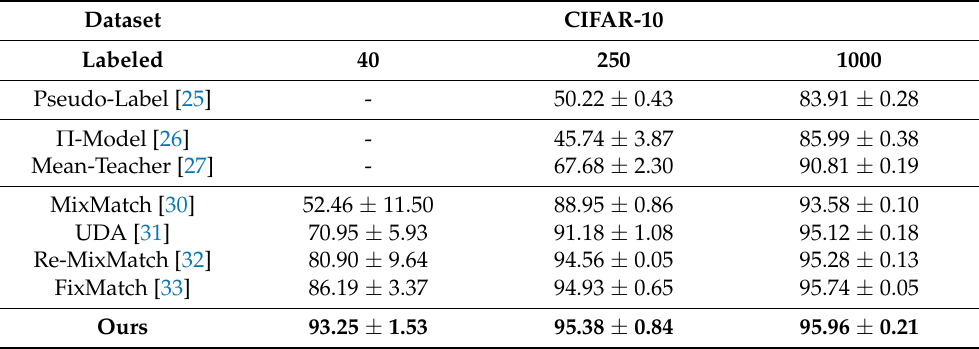
Table 1. Accuracy of different models using different numbers of CIFAR-10 labeled samples on the test set.